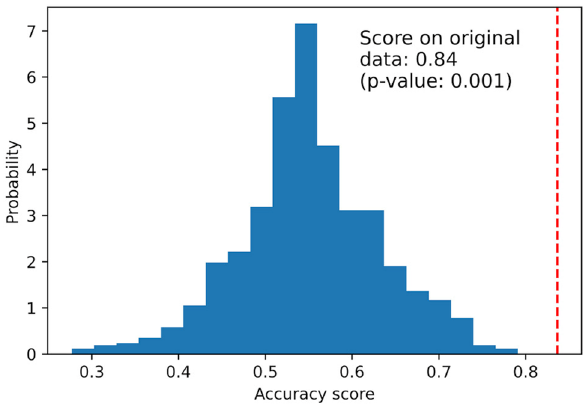
Figure 2. Permutation test results with the original dataset (permutation test scores for the classifier of MaxGD ≥ 242.3 μm). The distribution of accuracy score for the permuted data is illustrated as blue histograms. It represents the result of 5000 permutation tests for assessing classifier performance when selecting the 60 most discriminative variables. The red dotted line indicates the accuracy score value (0.84) obtained by the classifier in the original dataset (permutation P-value, 0.001). Abbreviation: GD, glomerular